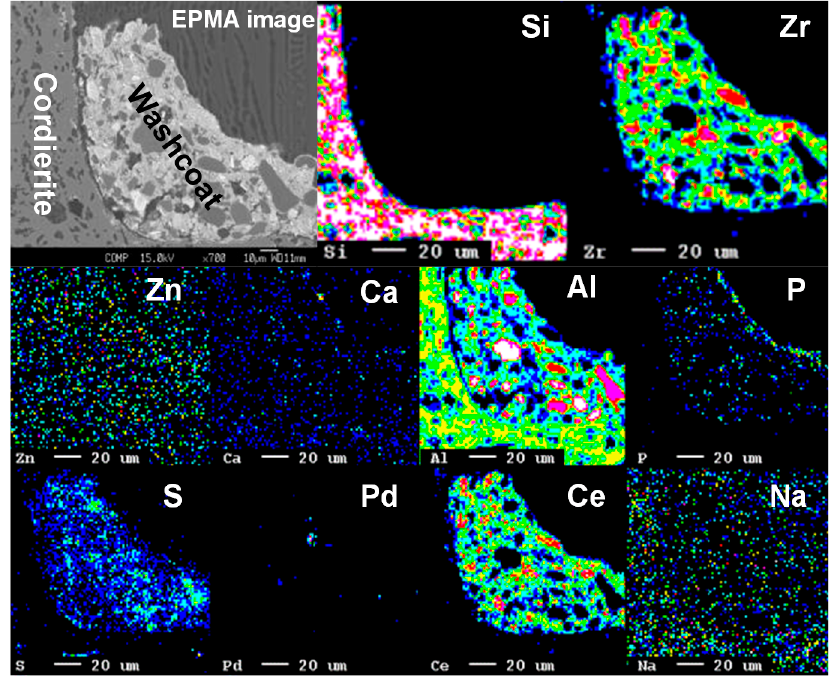
Figure 3. Electron probe microanalysis (EPMA) elemental maps for the inlet of FUL_AR.